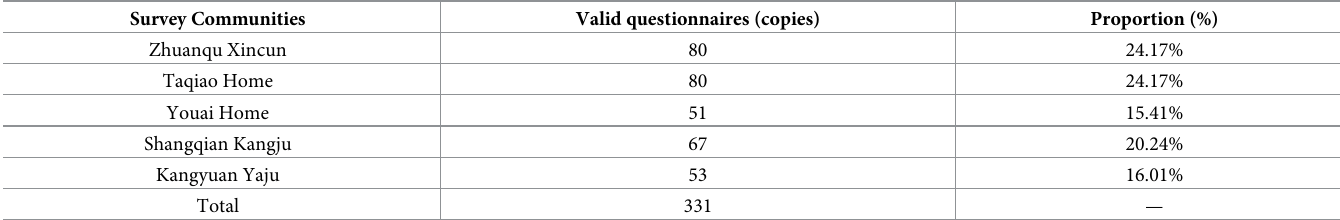
Table 2. Survey questionnaire distribution and validity. Survey